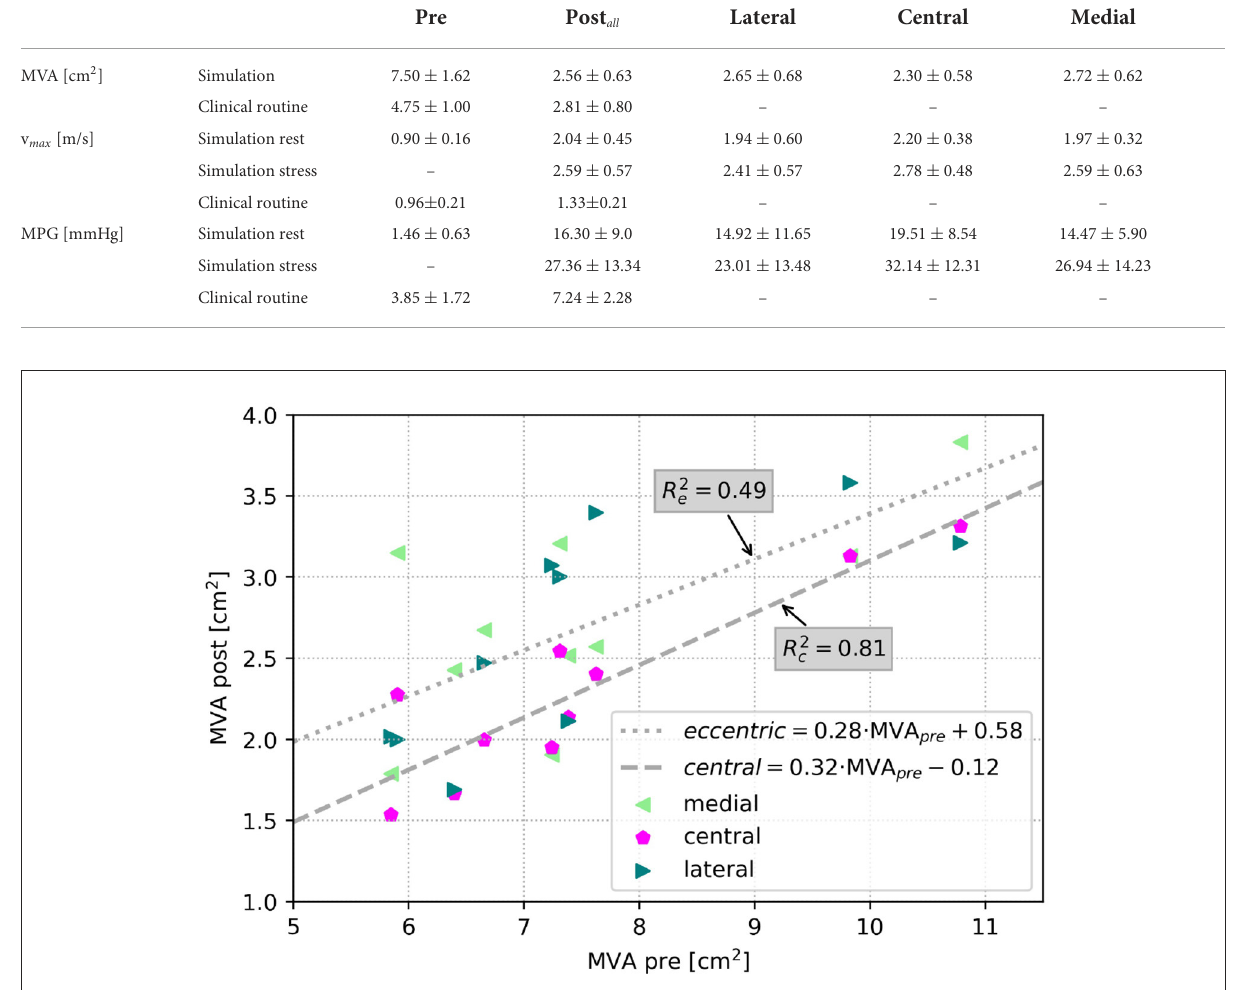
FIGURE6 Scatter plot of MVA in the simulation cohort after virtual TEER at all positions respective to MVA before virtual treatment. The dashed line shows a regression of central device positions (R 2 c = 0.81), and the dotted line shows the regression for eccentric device positions (R 2 e = 0.49).